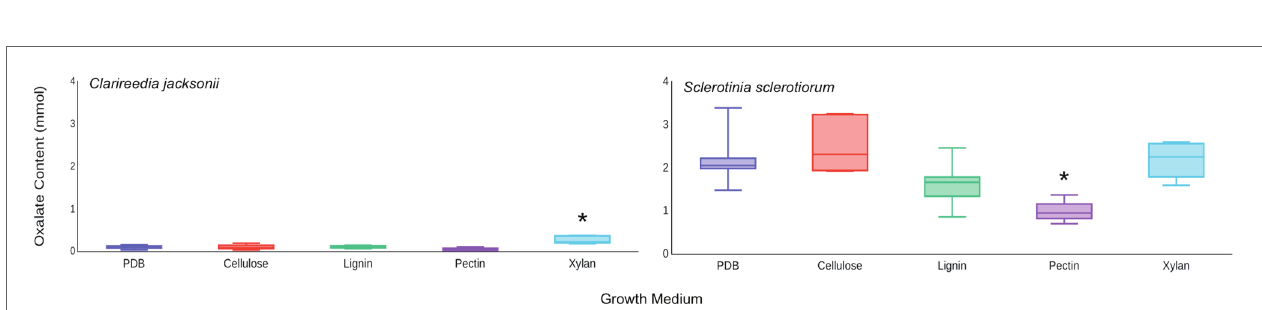
FIGURE 4 | Effect of creeping bentgrass clippings on OA production by C. jacksonii and Sclerotinia sclerotiorum . OA content was quantified for culture filtrates of C. jacksonii isolate OJN9 and S. sclerotiorum isolate SS#21 grown in PDB with (PDB + G) or without (PDB) grass amendments for a 1-week period (168 h). OA production by C. jacksonii was significantly increased in plant tissue-amended medium ( p < 0.001, * ) but similar for S. sclerotiorum regardless of treatment ( p = 0.23, NS). The experiment was repeated twice over time with a minimum of three replicates per treatment in each repetition. Median and first-third quartile intervals are